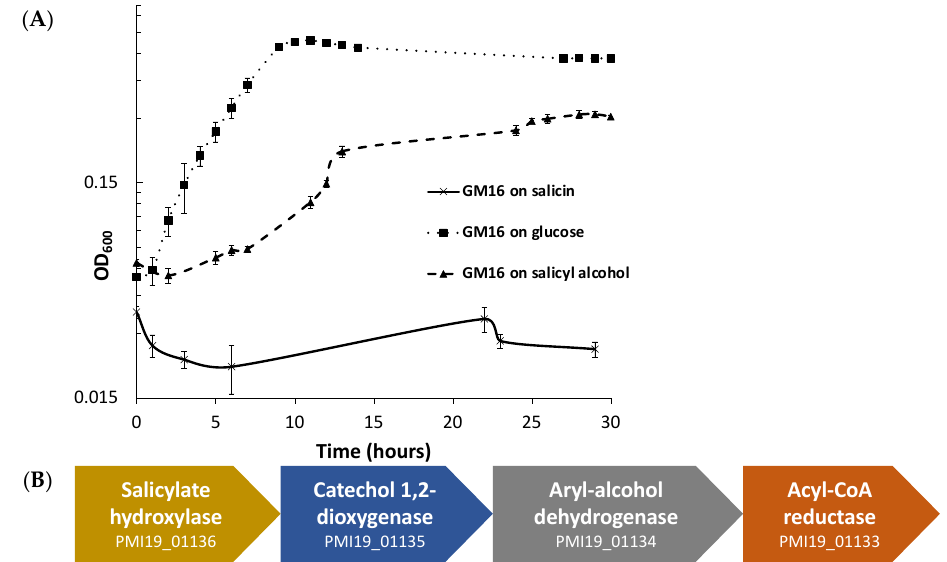
Figure 1. P. fluorescens GM16 can utilize salicyl alcohol, but not salicin. ( A ) Growth experiments were performed to determine the substrates P. fluorescens GM16 can utilize. As a positive control, glucose was used. Pseudomonas was able to grow on glucose and salicyl alcohol minimal media but could not metabolize salicin. ( B ) The genes of the cluster provided in the figure are proposed to encode proteins involved in salicyl alcohol degradation such that salicyl alcohol is oxidized to salicylate first, before being converted to catechol by the action of salicylate hydroxylase. The locus tag numbers for respective genes are prefixed with “PMI19_”.